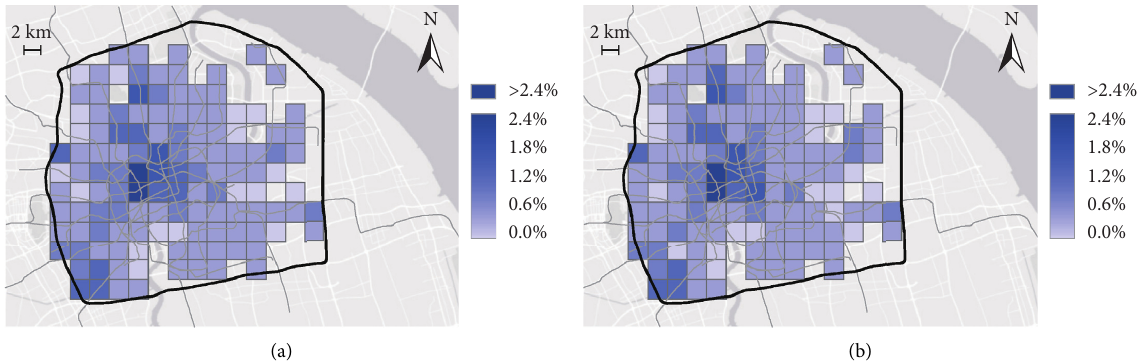
Figure 3: Spatial distribution of demand for package delivery (source: authors’ revision based on the Shanghai Municipal Postal Ad- ministration). (a) Package demand distribution: outgoing and (b) package demand distribution: incoming.